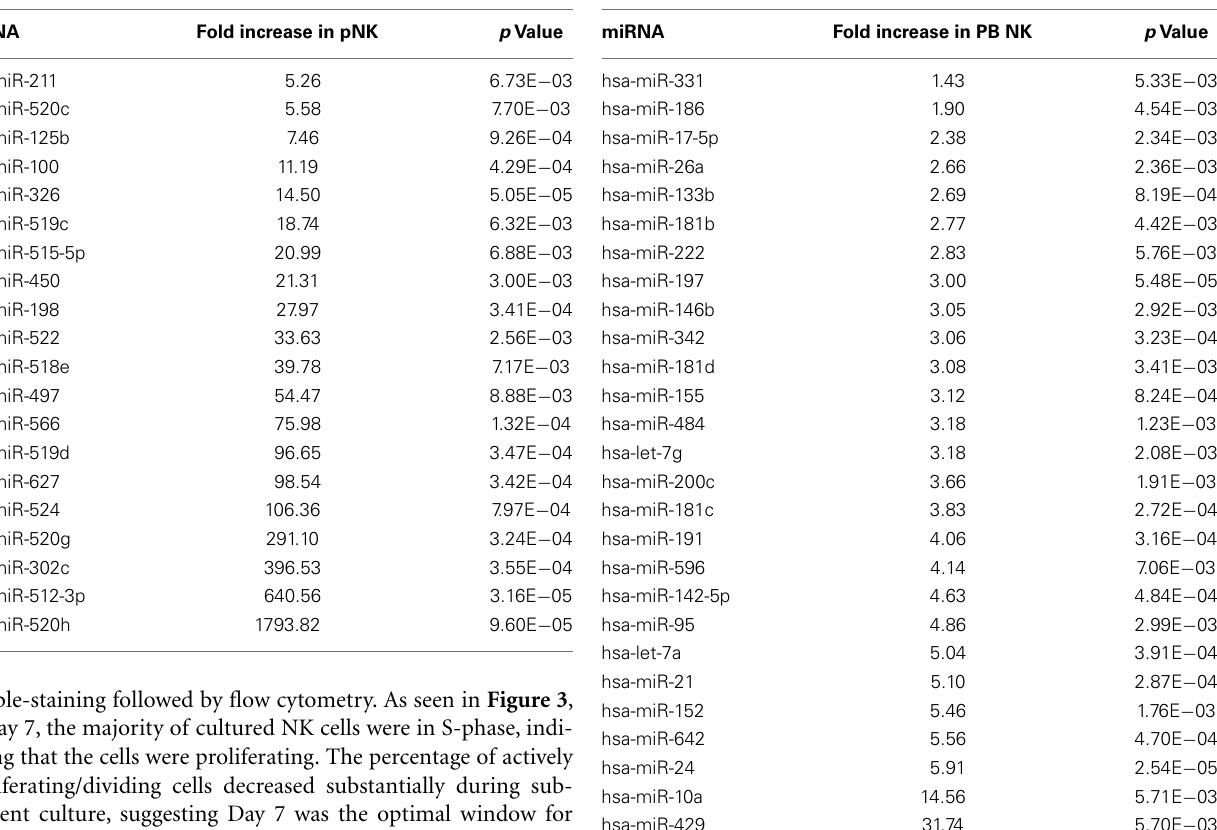
Table 3 | Highly expressed miRNAs in pNK cells. Table 4 | Highly expressed miRNAs in PB NK